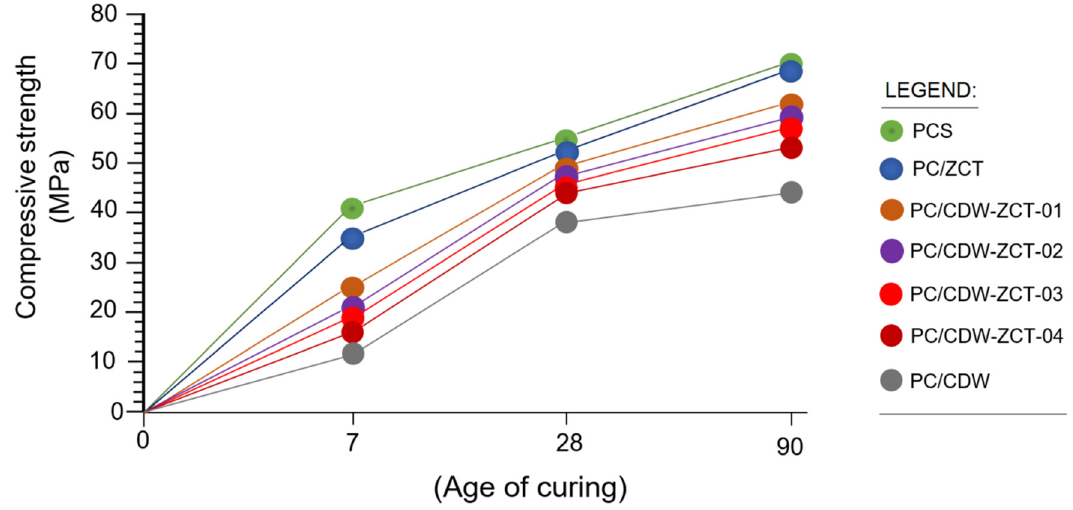
Figure 4. Mechanical strength to compression determined for specimens made with PCS, PC/ZCT, PC/CDW-ZCT and PC/CDW at 7, 28 and 90 days of curing.